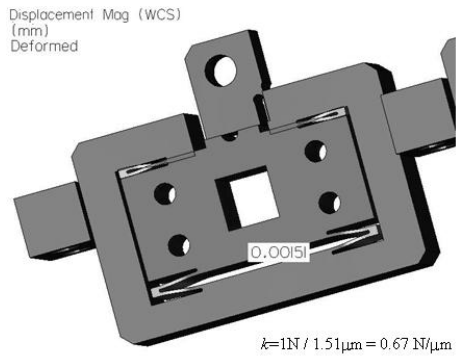
Figure 5. Static FEA of the z